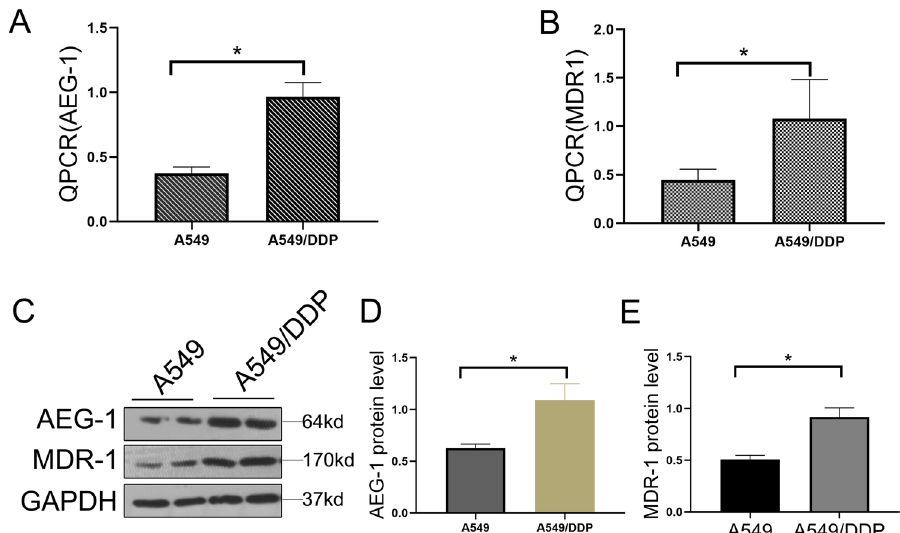
Figure 1. The expression of AEG-1 and MDR-1 in A549 and A549/DDP cells. ( A ) The expression of AEG-1 in mRNA level. ( B ) The expression of MDR-1 in mRNA level. ( C ) The expression of AEG-1 and MDR-1 in protein level. ( D – F ) Quantitative analysis of AEG-1 and MDR-1 protein